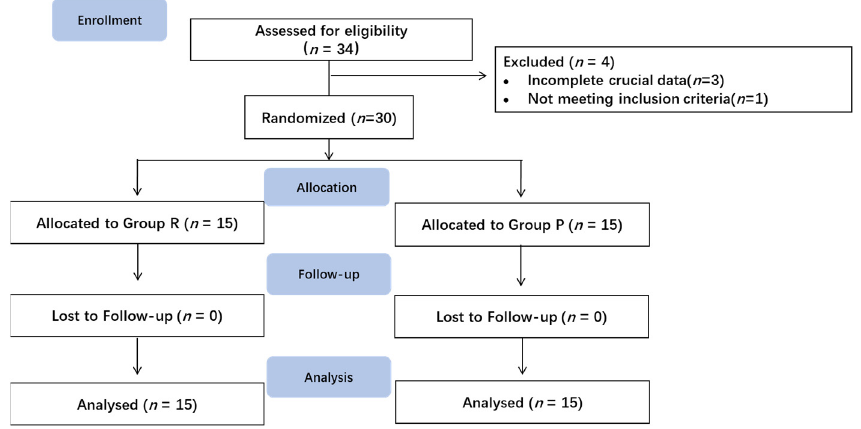
Figure 2. Enrollment diagram.